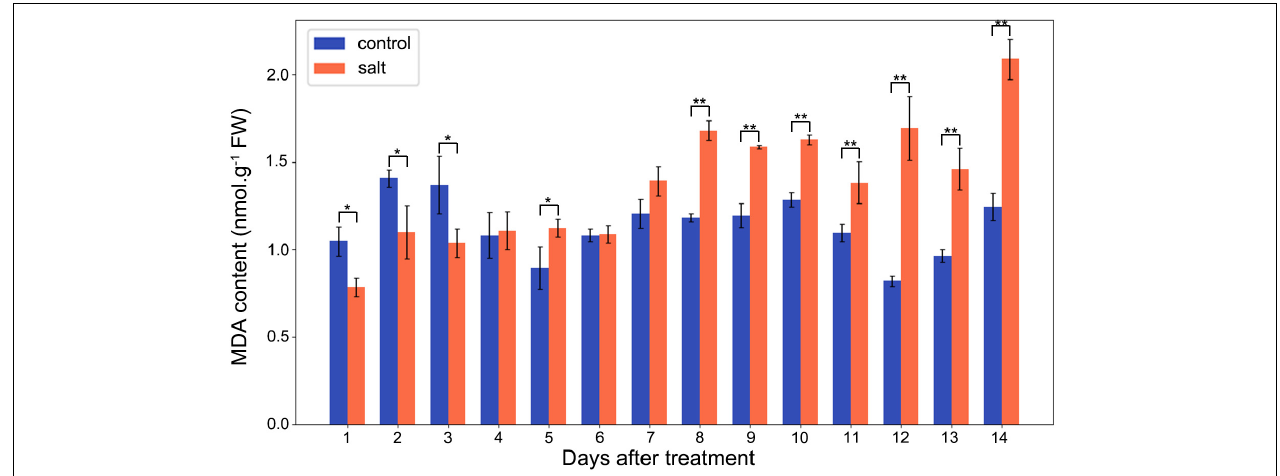
FIGURE 5 | Changes in MDA contents in the control and salt-treated M. crystallinum seedlings. The blue dots represent the control group and the orange dots represent the salt-treated group. The error bar represents standard error. An asterisk indicates a Student’s t- test ( p < 0.05) and two asterisks indicate a Student’s t- test ( p < 0.01). The data were obtained from four biological